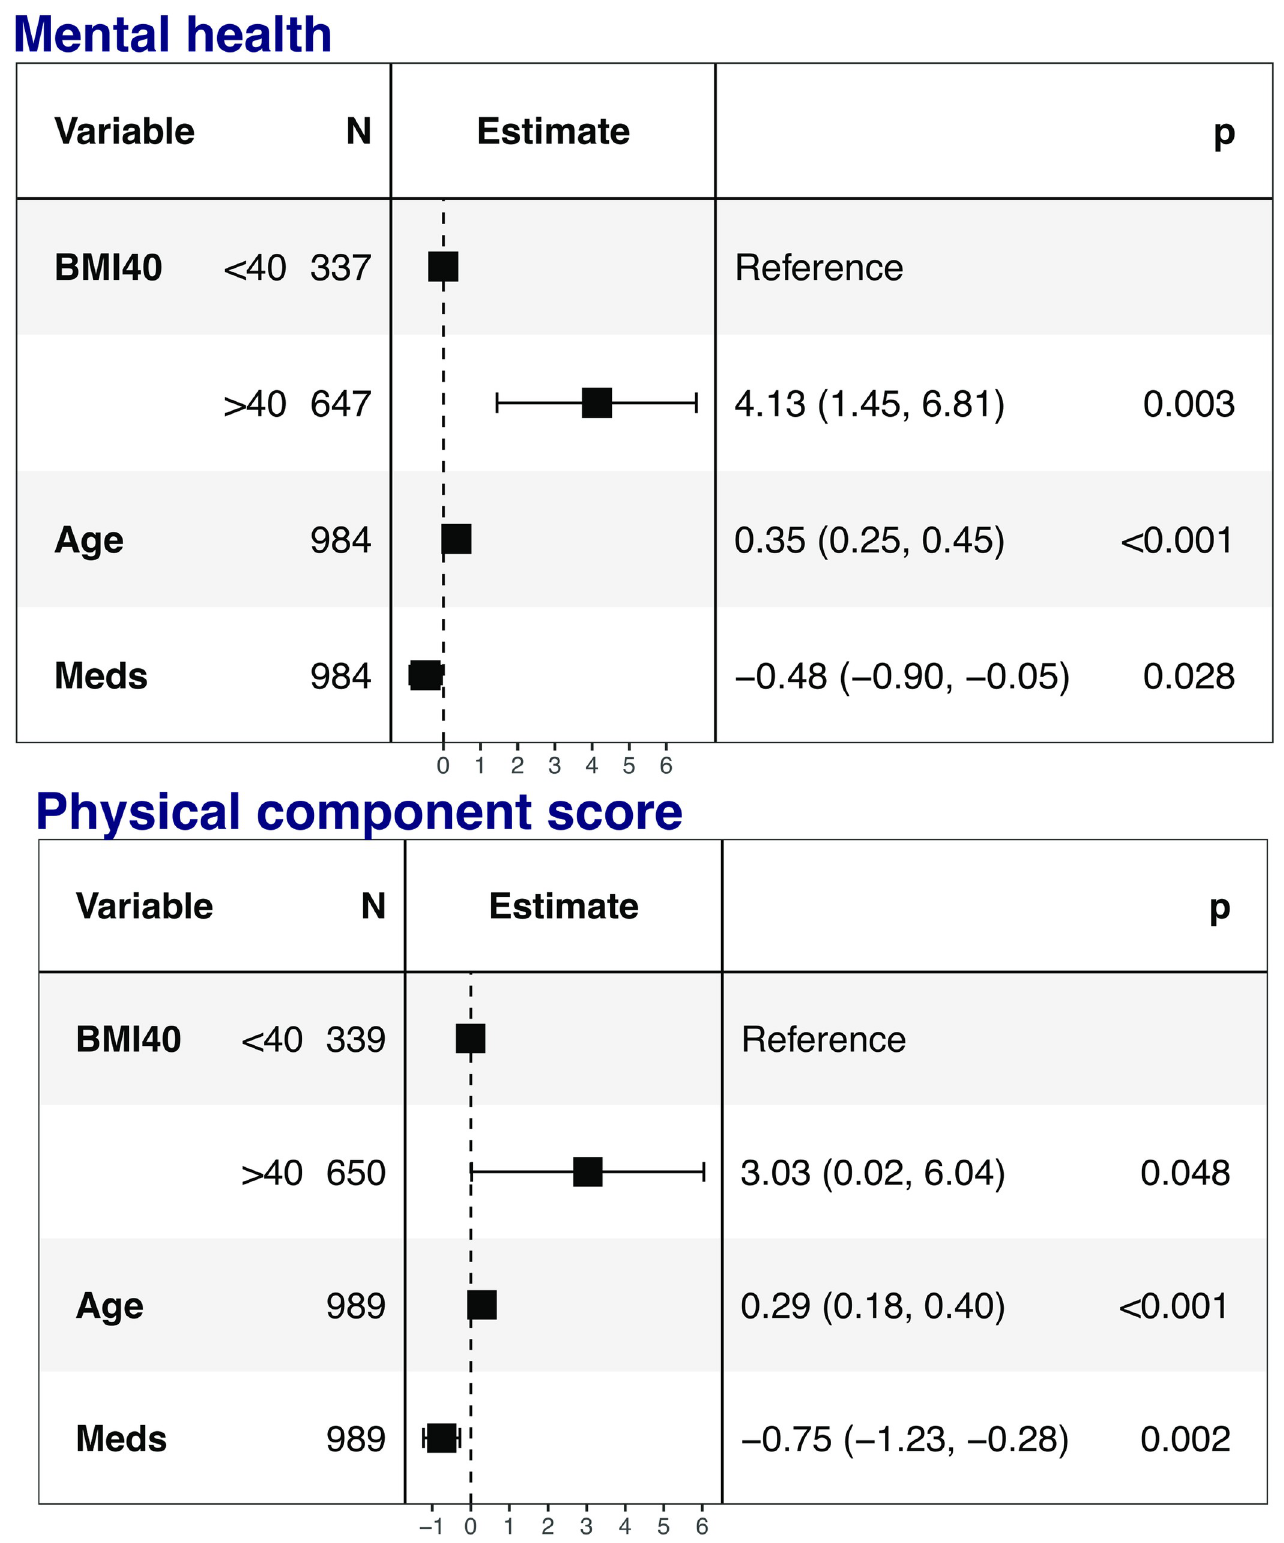
Fig 2. Results of a multiple linear regression for evaluation of association between health-related quality of life indicated by the Rand-36 instrument and BMI category (BASUN population with obesity) for the Mental health and Physical Component Score (PCS) domains. The model is adjusted for age and number of medication (Meds) and results presented as beta coefficients with 95% confidence